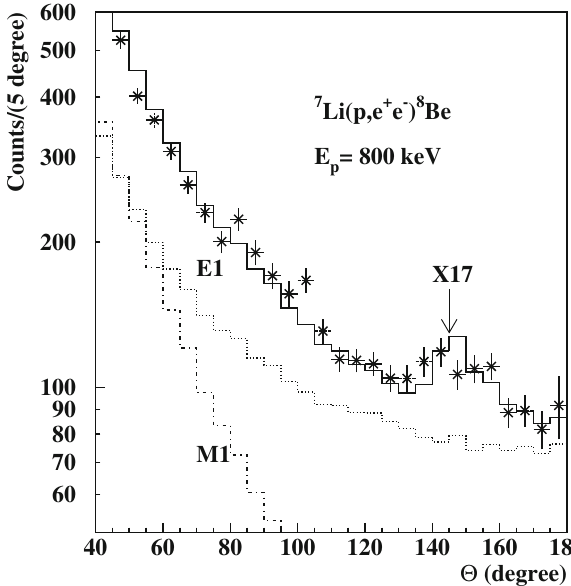
Fig. 6 Comparison of the experimental and the simulated angular cor- relations of the e + e − pairs obtained from the 7 Li ( p , e + e − ) 8 Be reaction at a proton bombarding energy of 800 keV. The best fitted sum (solid line) as sum of the simulated background for E1 (dotted line) and M1 (dashed line) transitions and the simulated contribution of the hypothet- ical X17 boson is compared with the experimental signal values (snow flakes with error